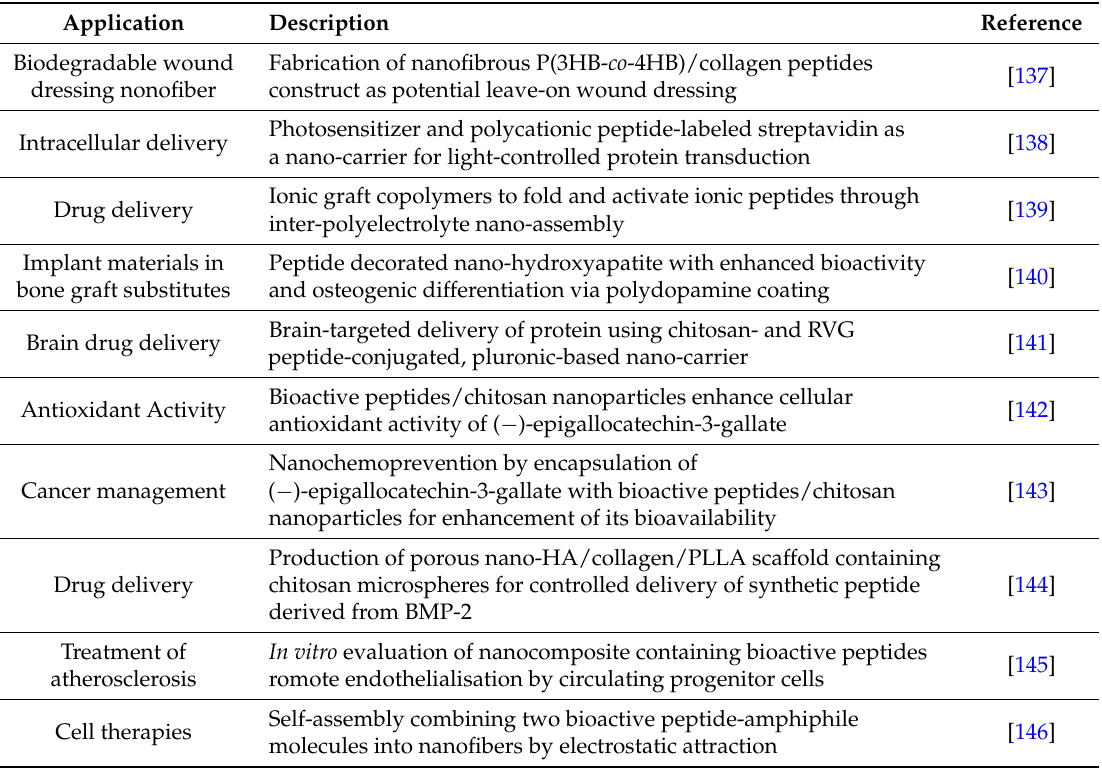
Table 5. Application of bioactive peptides using